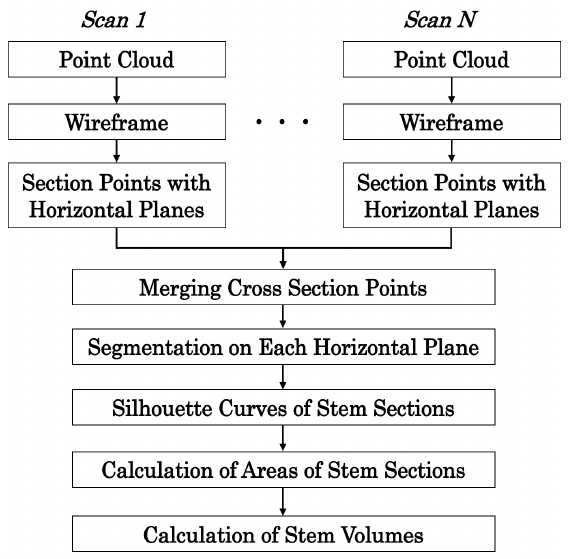
Figure 5. Calculation